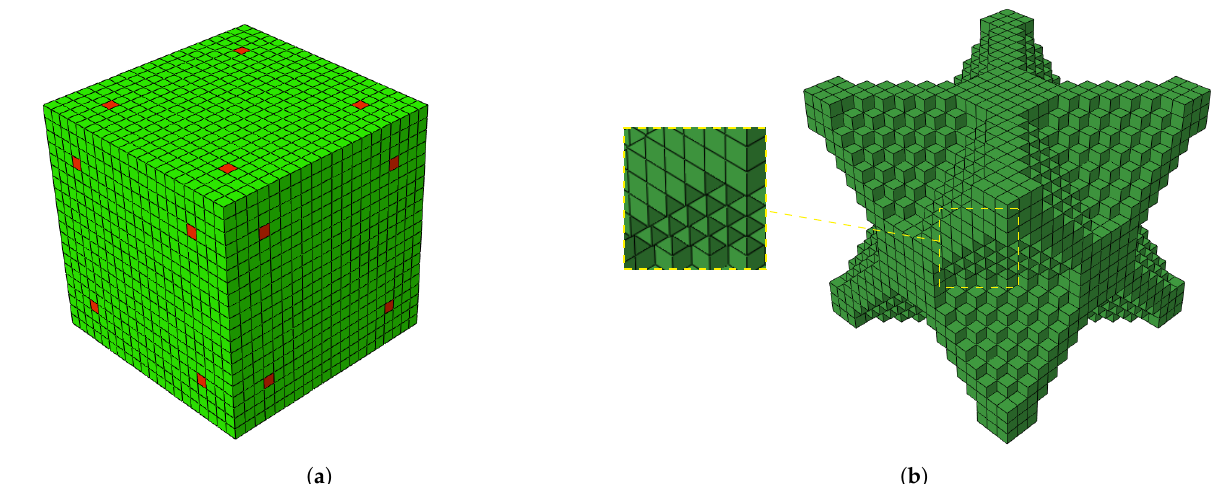
Figure 1. TO design domain discretization using an FEM hexahedral mesh (cubes): ( a ) initial design domain; ( b ) final optimized